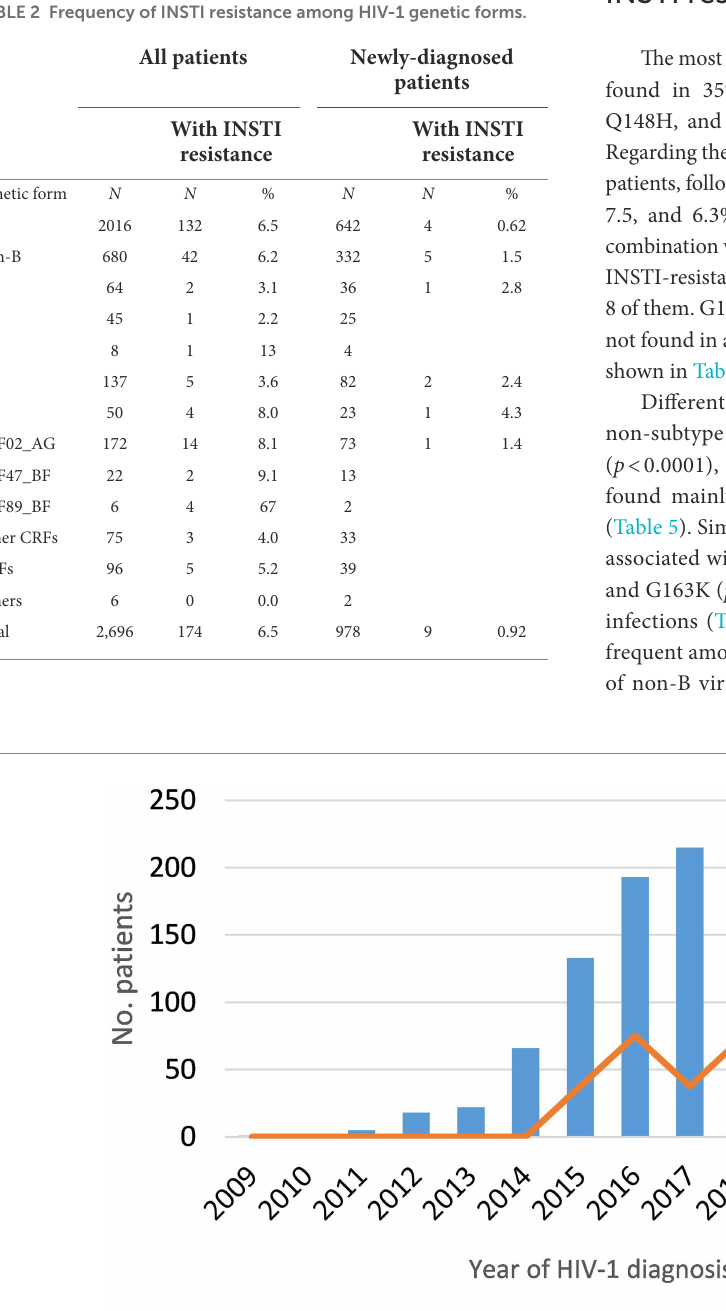
TABLE 2 Frequency of INSTI resistance among HIV-1 genetic